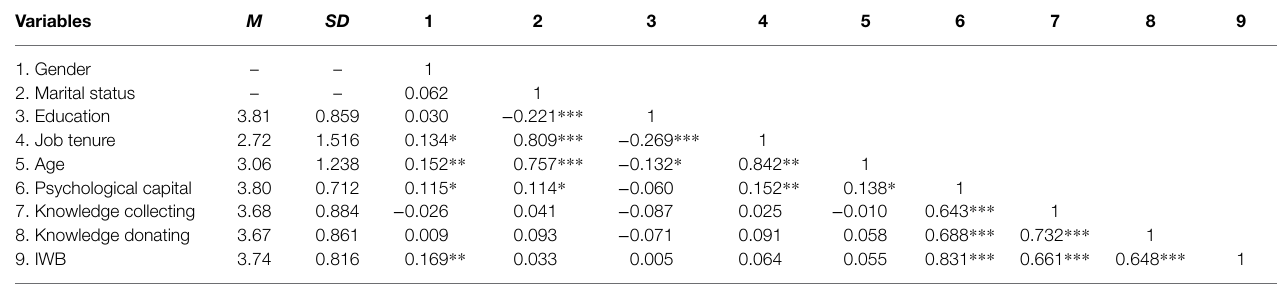
TABLE 1 | Descriptive statistics and correlations among all variables.